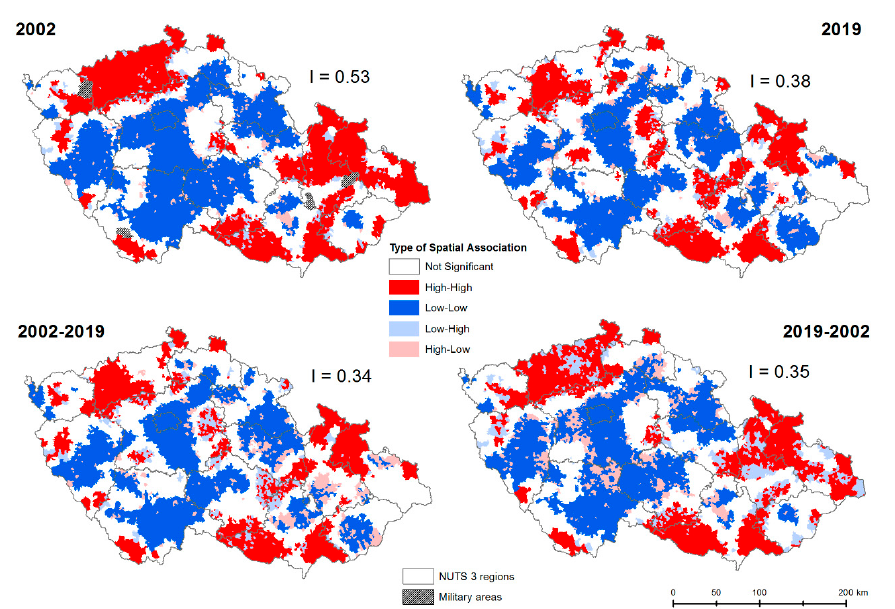
Figure 4. Univariate and bivariate local indicators of spatial association (LISA) cluster maps for unemployment between 2002 and 2019 in Czechia (municipal level). Source: Ministry of Labor and Social Affairs, Labor Office of the Czech Republic; own calculation. Note: All LISA cluster maps are calculated for distance-based spatial weights with fixed Euclidean distance and a threshold distance of 10 km.